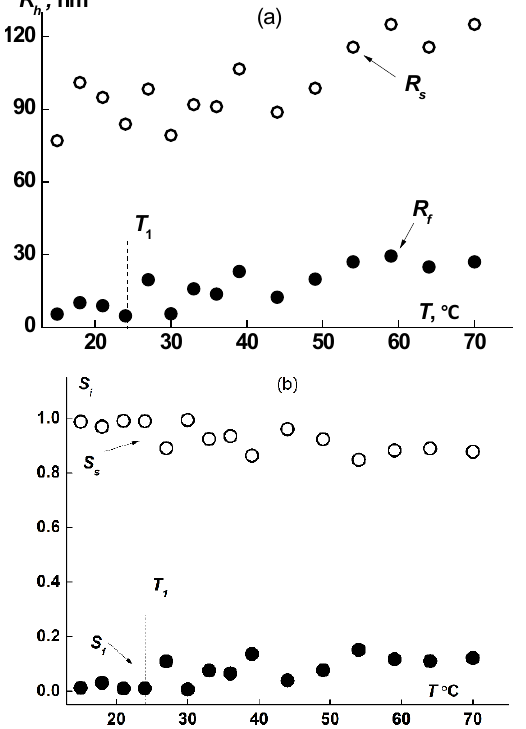
Figure 9. Progress of hydrodynamic size ( a ) and S i ( b ) (i is f or s) upon heating for fast and slow modes in sample 3 aqueous solution at c = 0.016 g/cm 3 .